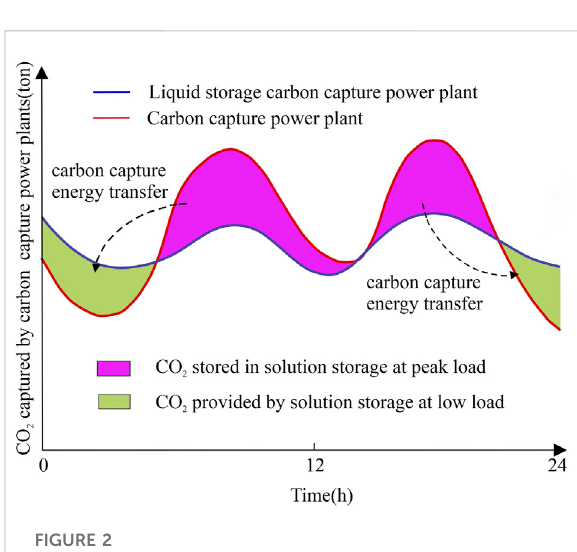
FIGURE 2 Schematic diagram of carbon capture transfer in